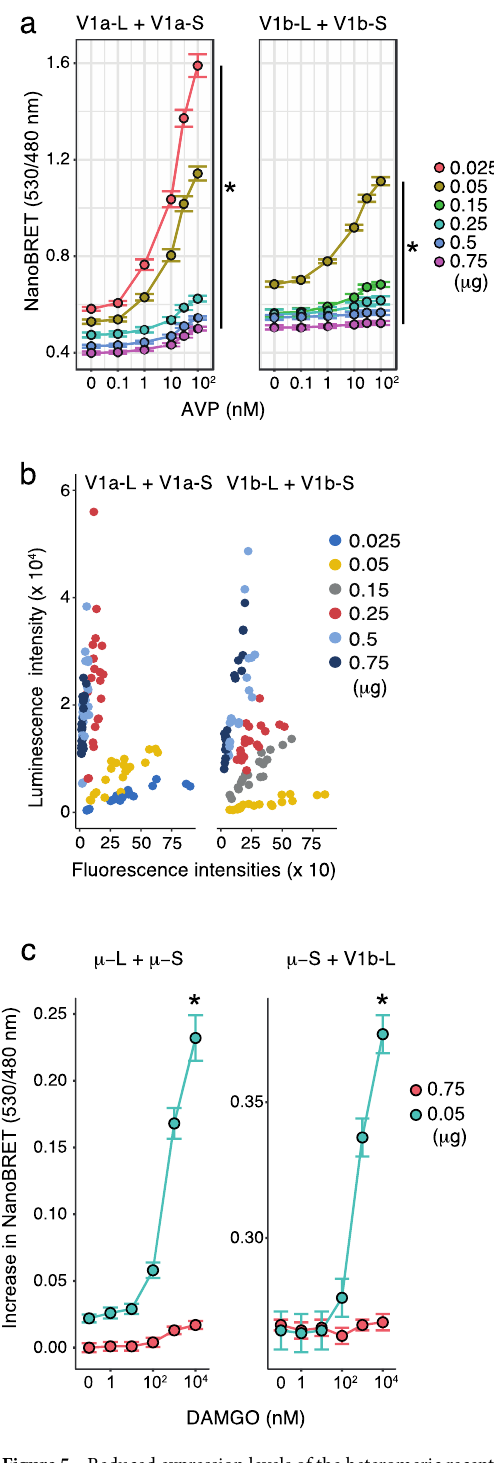
Figure 5. Reduced expression levels of the heteromeric receptors increased the intensity of the NanoBRET signals between heteromeric receptors and β-arrestin 2. ( a ) NanoBRET measurements were performed to monitor a complex formation among receptor homodimer and β-arrestin 2. Cells were transfected with the indicated amounts of receptor-LgBit and receptor-SmBit plasmids and a fixed amount (1.5 μg) of β-arrestin 2-Venus. Reduced plasmid amounts of the receptor-LgBit and receptor-SmBit significantly increased the NanoBRET signals. (n = 10) *indicates that the plasmid amount of receptor constructs was a significant determinant in the BRET responses ( p < 0.001). ( b ) Relationship between the luminescence from receptor-homomer-NanoBit and the fluorescence from β-arrestin 2-Venus. The plasmid amounts of the receptor constructs in a 35 mm dish are indicated. (n = 10) ( c ) The homodimeric μ-receptor and heterodimeric μ-V1b receptor recruited β-arrestin 2-Venus with a large NanoBRET signal when the expression levels of the receptors were reduced. The indicated amounts of the receptor plasmids were cotransfected with 1.5 μg of β-arrestin 2-Venus into cells growing in a 35 mm dish. (n = 10) *indicates that reduced amounts of the receptor plasmids significantly increased the BRET responses ( p < 0.001). The statistical computer program R version 4.0.3 (R Core Team, [2020], Vienna, Austria. https:// www.r- proje ct. org) was used to prepare Fig.